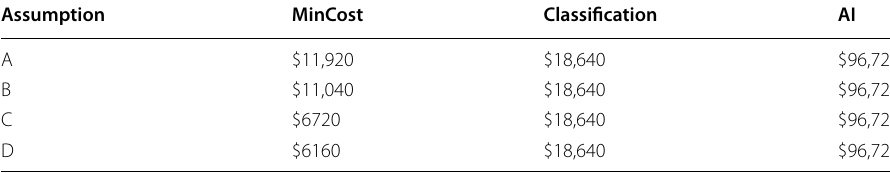
Table 5 Cost results averaged over tenfold for each assumption scenario Assumption